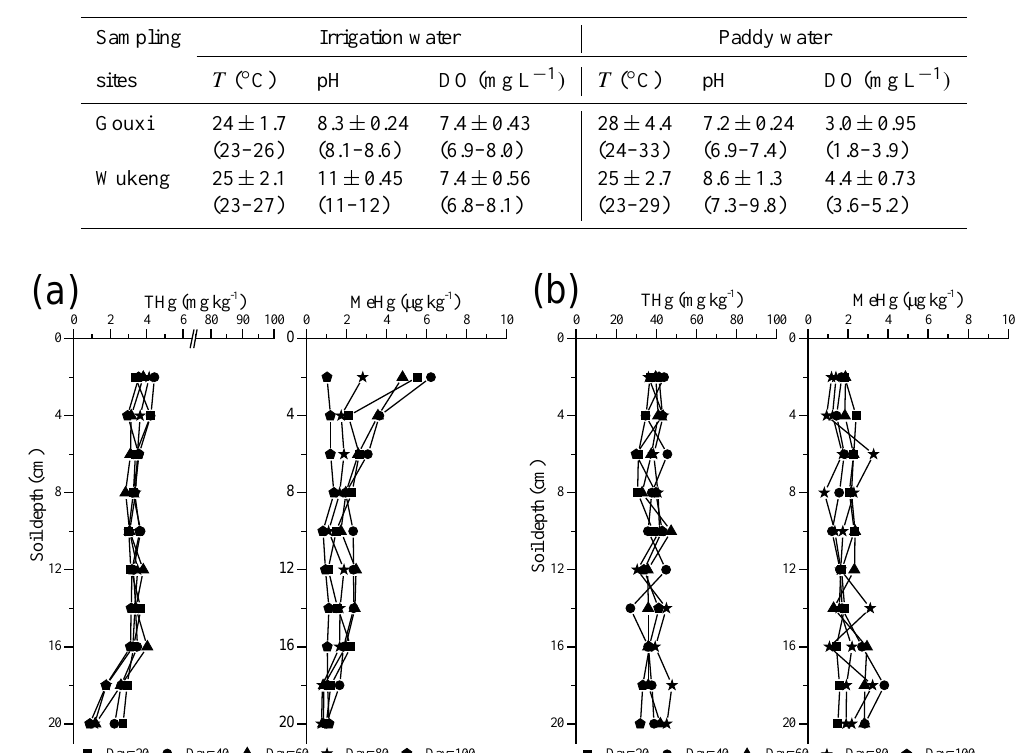
Table 4. Temperature ( T ), pH, and dissolved oxygen (DO) in irrigation water and paddy water at the artisanal Hg mining site (Gouxi) and abandoned Hg mining site (Wukeng; mean ± SD, range).